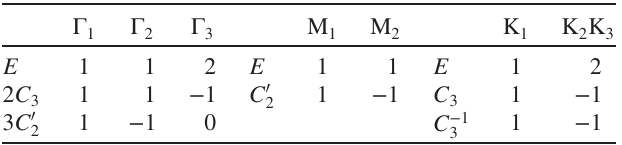
TABLE IV. Character table of irreps at high symmetry